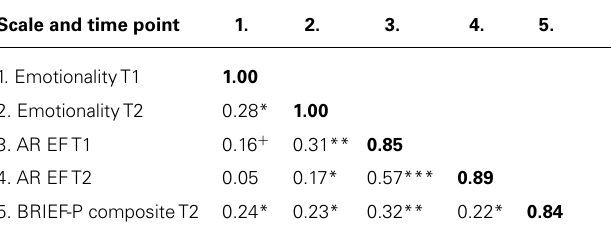
Table 3 | Inner model latent variable